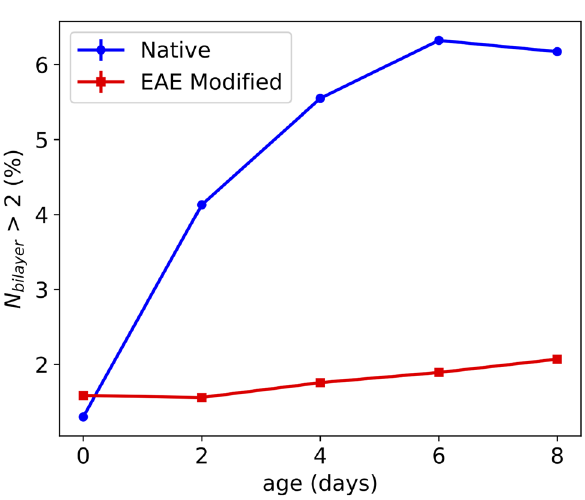
Figure 3. Kinetics of MBP-mediated assembly process followed by SAXS. SAXS data of ( a ) native and ( b ) EAE modified membranes mixed with 16.7 wt. ratio MBP 0, 2, 4, 6 and 8 days before the measurement. In c) and d) cryo-TEM pictures of aged native (5 days) and EAE modified (6 days) liposomes with 16.7 wt. ratio MBP are shown. The black bar in ( c ) corresponds to 500 nm and in ( d ) to 100 nm. For better visibility the different datasets in ( a ) and ( b ) have been vertically shifted. In c) some of the rounded edges and in d) some of the sharp edges have been marked by red arrows. The samples for SAXS and cryo-TEM were taken from the same batch for better comparison and had a lipid concentration of 5 mg/ml.